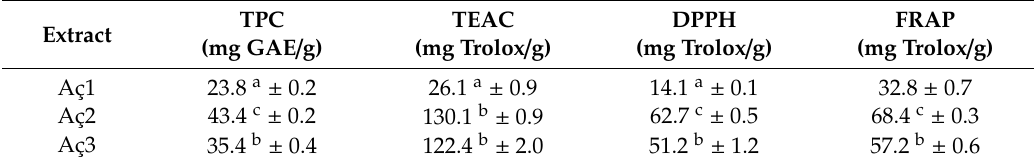
Table 1. Polyphenolic content and antioxidant capacities results of aça í fruit extracts. TPC TEAC Extract